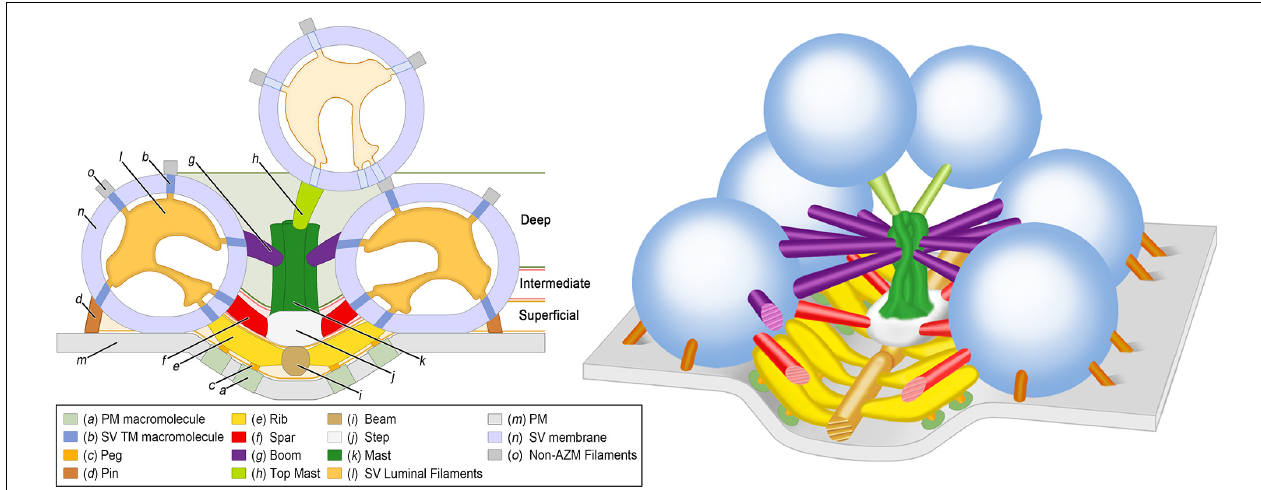
FIGURE 1 | Organization of AZM and SVs at an active zone of a frog NMJ. 2D (Left) and 3D (Right) schematic diagrams derived from electron tomography analysis of active zones showing the positions, dimensions, and connectivity of AZM macromolecules to SV membranes and the PM (see legend for color codes). Docked SVs are in direct contact with the PM whereas undocked SVs are not. The SV luminal filaments and SV transmembrane (TM) macromolecules are ghosted in the undocked SV because their orientations and spatial relationships to AZM and non-AZM macromolecules have not been observed directly. The AZM band is ∼ 1 mm long and is composed of 5–10 repeats of the unit shown in the 3D schematic diagram on the right. Adapted from Harlow et al. (2001), Szule et al. (2012), and Harlow et al. (2013). NMJ, Neuromuscular junction; AZM, Active zone material; PM, Presynaptic membrane; SV, Synaptic vesicle.